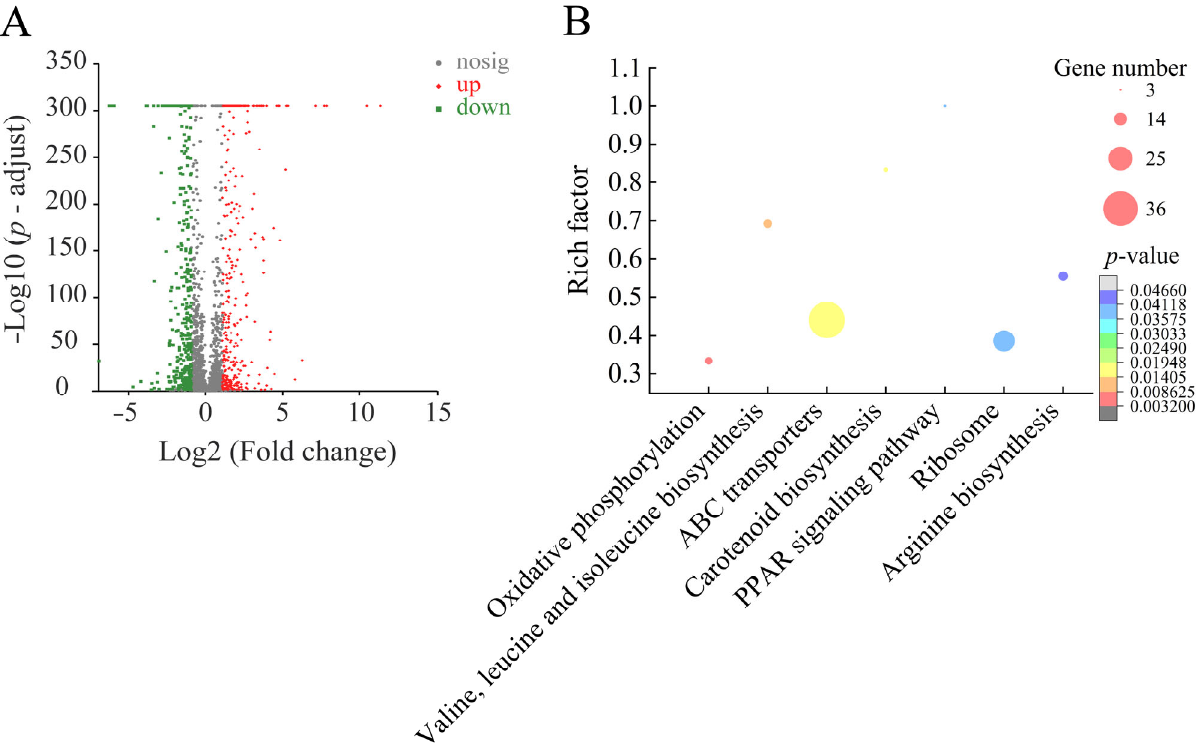
Figure 7. The seven significantly altered metabolic pathways in S. aureus ATCC25923 mediated by Fragment 1 from C. communis Linn. ( A , B ) Volcano plot of differential gene expression and significantly changed metabolic pathways in S. aureus ATCC25923, respectively.